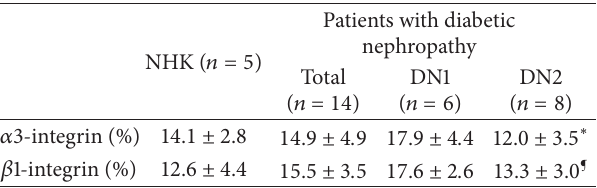
Table 2: Percentages of cells positive for integrin mRNAs in